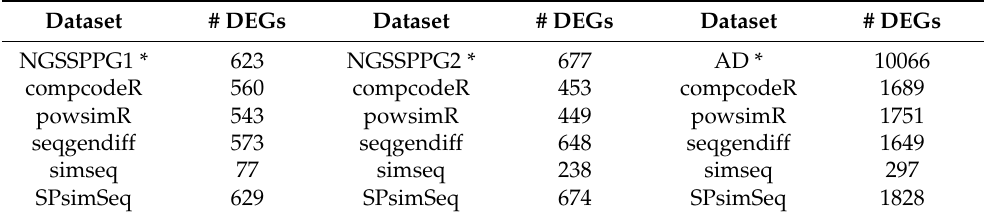
Table 1. DEGs found by DESeq2 from datasets simulated based on either the NGSSPPG1 (100 sam- ples, 10,000 features, class ratio = 50/50) data or the AD data (100 samples, 34,616 features, class ratio = 50/50). All generators are set to produce data with 5% DEGs. Asterisk (*) denotes the original dataset; the subsequent rows indicate datasets generated with it as